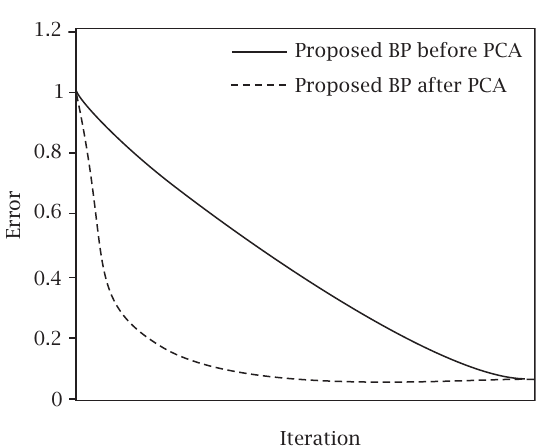
Figure 5.1 . Convergence rate for handwritten digits before and after PCA of group I.